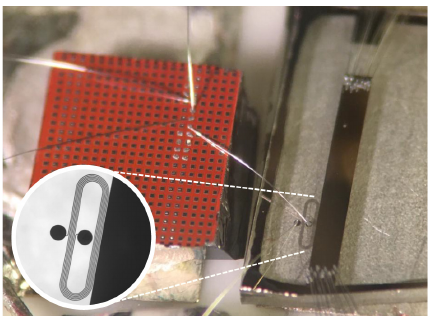
FIG. 6. Photograph of the multimodule setup. The silicon chip with an array of square bond pads is seen to the left, and to the right is the NbN-on-sapphire substrate. The two modules are positioned adjacent to each other on a printed circuit